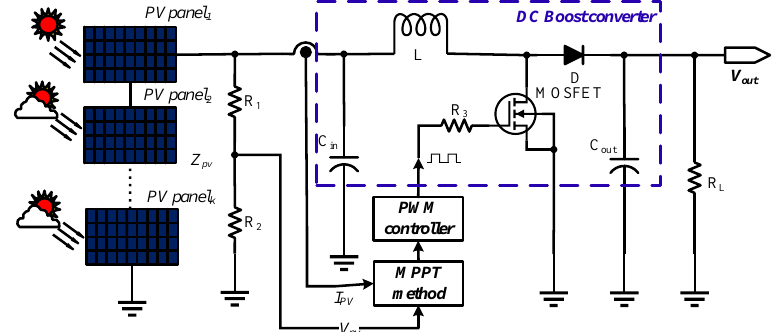
Figure 4. PV power conversion system with the boost converter.